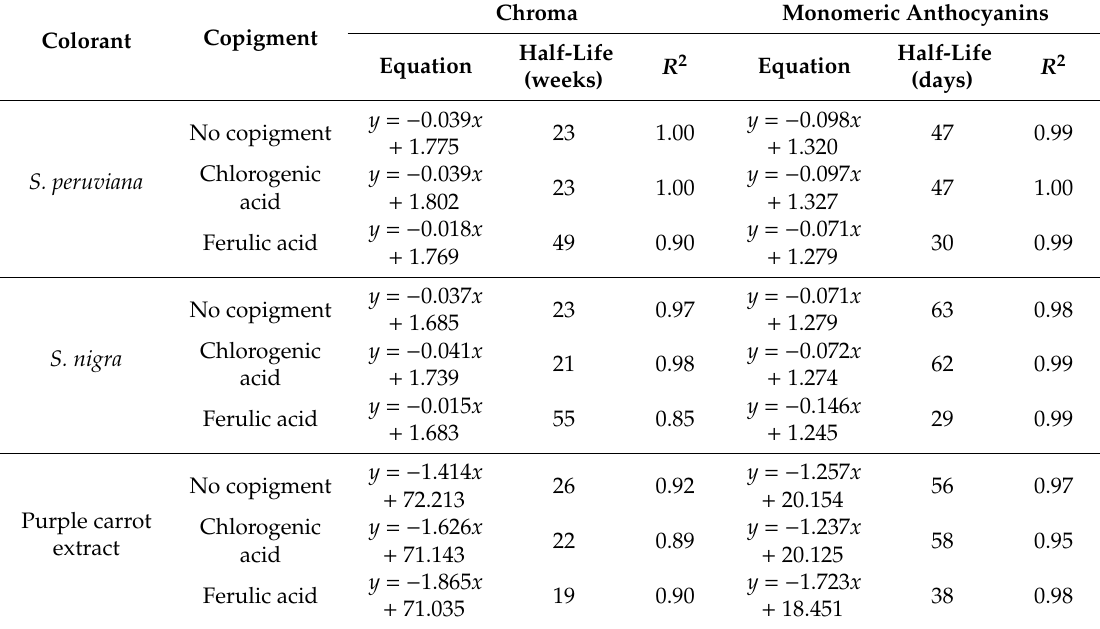
Table 2. Degradation models and half-lives of color chroma and monomeric anthocyanins in model beverages with and without